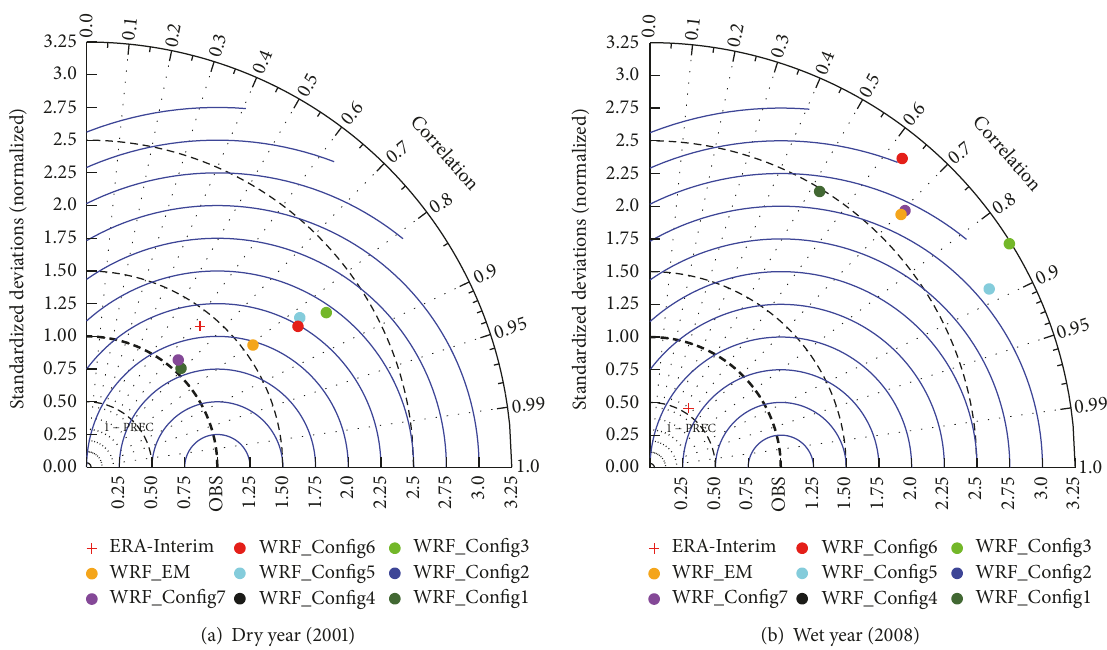
Figure 5: Taylor diagram showing the statistical summary for the coastal zone for the (a) dry year (2001) and (b) wet year (2008).